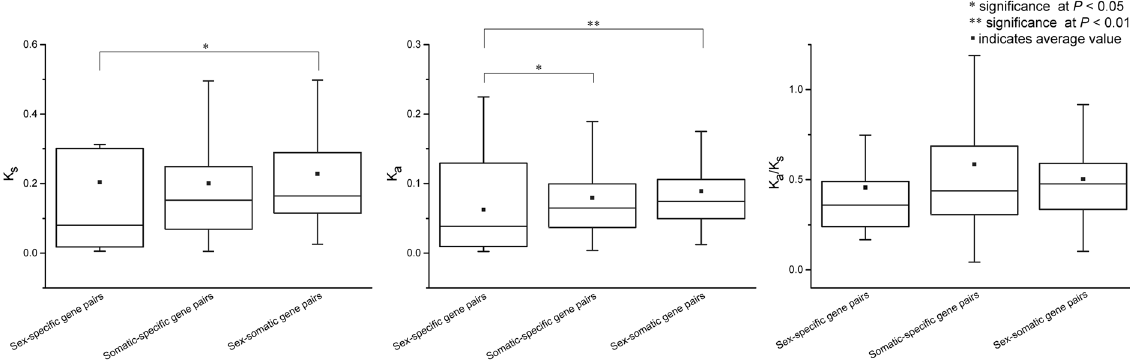
Figure 3. Comparison of K s , K a , and K a / K s of duplicated gene pairs in sex-specific, somatic-specific, and somatic-sex